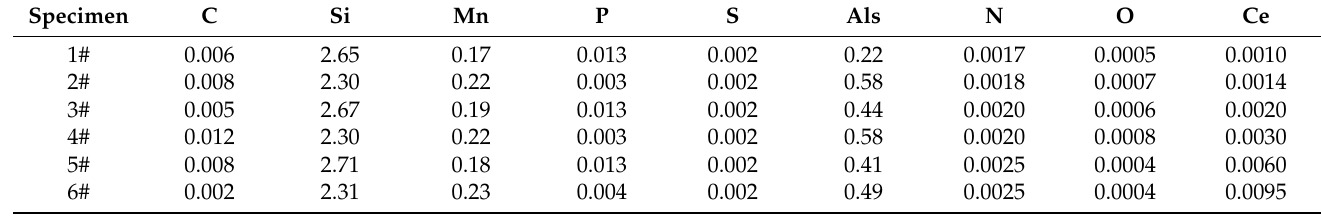
Table 3. Chemical composition of experimental steel (wt.%).